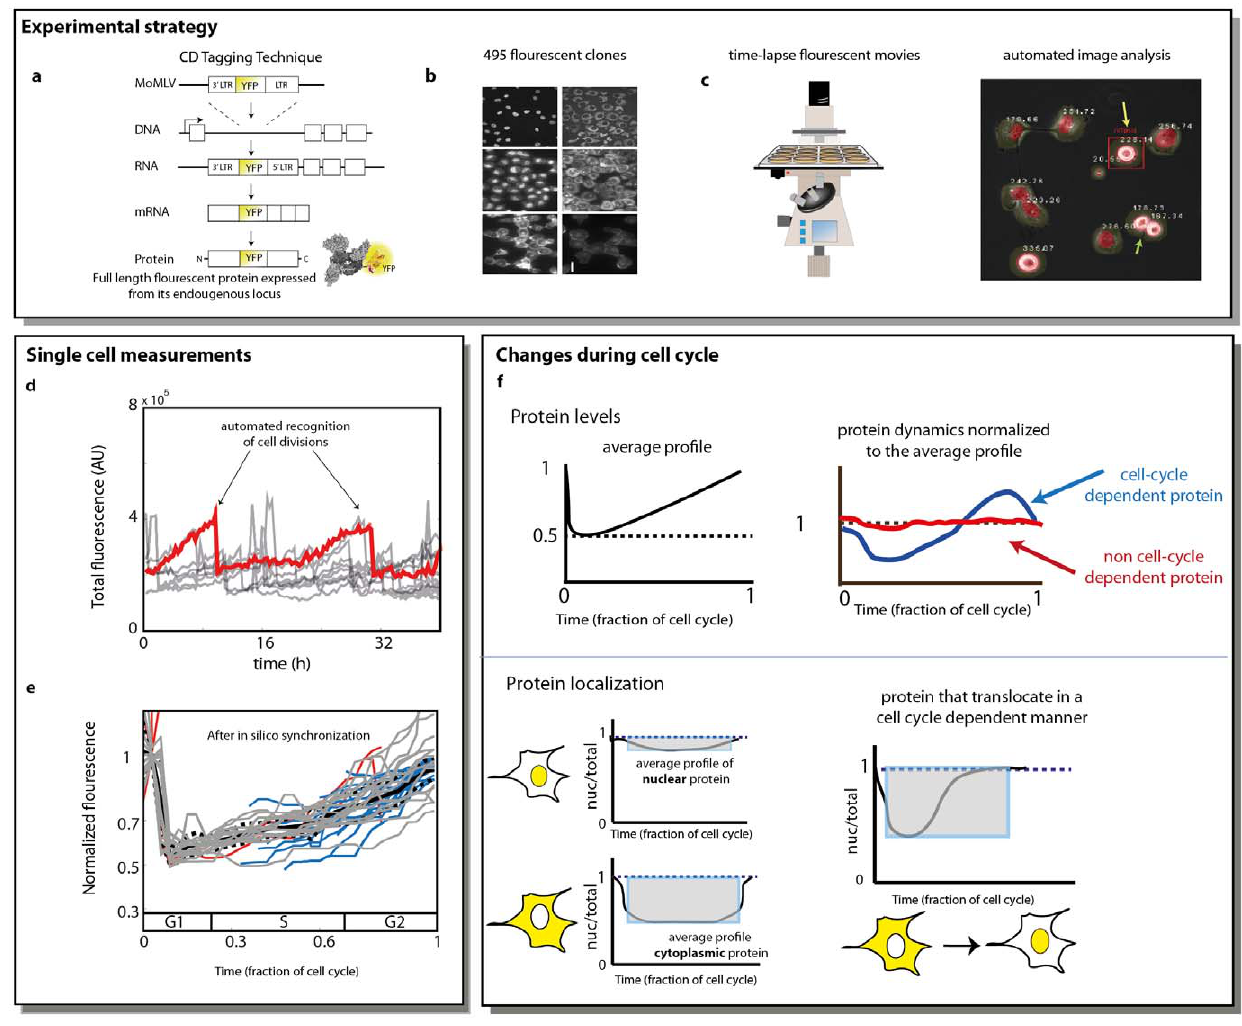
Figure 1. Schematic overview of dynamic proteomics for exploring cell cycle dependent changes in level and localization. (A) CD tagging was used to insert YFP as an exon into the introns of genes on the chromosome of a human cell line clone (H1299), resulting in a full length protein fused to YFP expressed from its endogenous locus. (B) A panel of 6 representative clones with different tagged proteins from the LARC library (C) Time-lapse microscopy and automated image analysis allow capturing proteins levels and localizations in individual cells over time. Yellow arrow indicates a cell in mitosis, green arrow indicates cells post mitosis. (D) Fluorescence traces of individual cells over a 40 hours movie (tagged protein is DDX5). Sharp decreases are at division events (E) In silico synchronization is done by plotting cell dynamics on a time axis which indicates time from previous or next division. Time is divided by mean cell cycle duration, to provide fraction of cell cycle elapsed. G, S and G2 phases are estimated from Sigal [15]. Grey lines- cells with two mitosis events in the movie, blue, red lines: cells with one mitotic event. The fluorescence level is normalized to the maximal level before cell division. (F) In silico synchronized dynamics are used to examine cell-cycle dependence on levels and localizations. On the top panel, Protein profile (blue) that is significantly different from the average profile (black) is considered cell cycle dependent. On the bottom panel : nuclear protein shows a nuclear ratio (nuc/total) profile close to 1 most of the cell cycle, while cytoplasmic protein, shows a nuclear ratio close to 0 most of the cell cycle (besides during the mitosis, where the nucleus and cytoplasm are hard to segment apart). Protein that change its localization from the cytoplasm to the nucleus in a cell cycle dependent manner, present a nuclear ratio that is variable across the cell cycle.